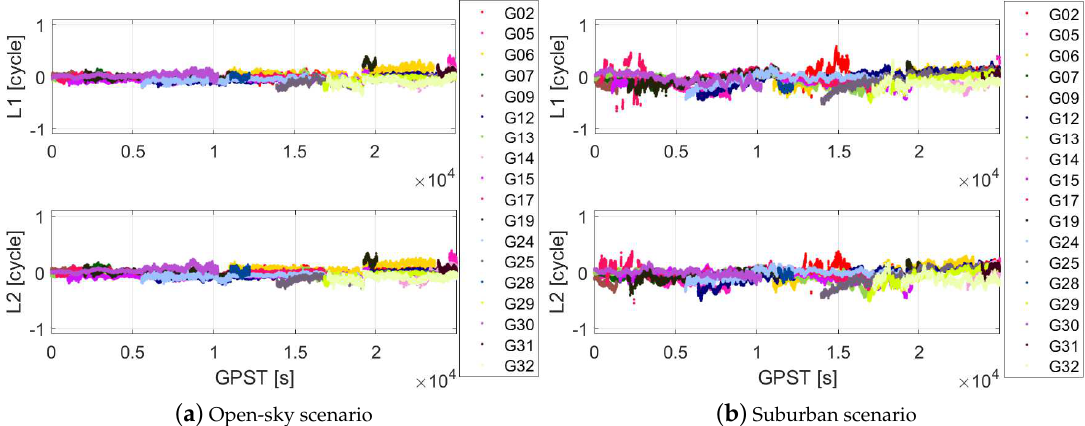
Figure 5. L1 and L2 residuals introducing the ground truth of the baselines and the resolved ambiguities for ( a ) the open-sky scenario and ( b ) the suburban